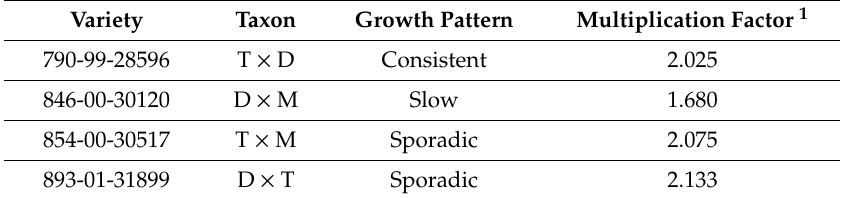
Table 4. Varietal performance during in vitro propagation on two-week sub-culturing schedules. Variety Taxon Growth